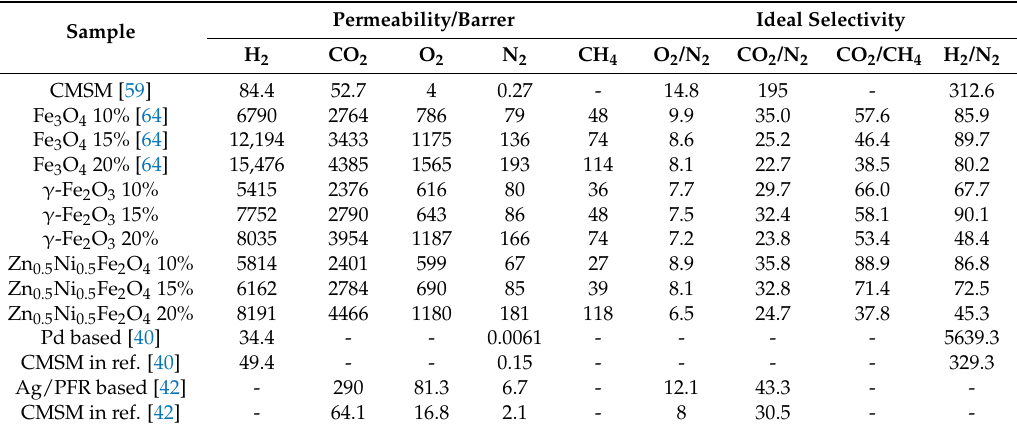
Table 3. Gas permeability and ideal selectivity of Fe series magnetic nanoparticle/C hybrid membranes.